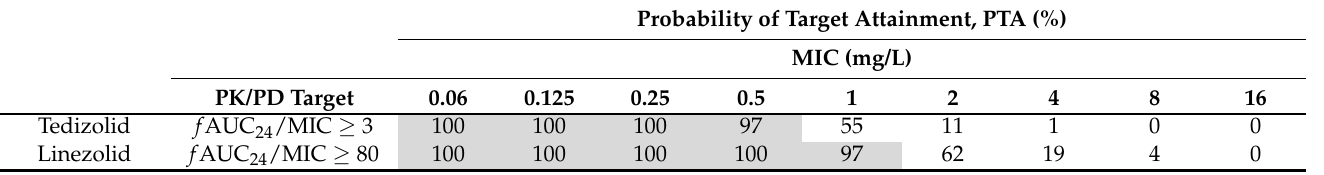
In grey PTA values ≥ 90% (high probability of